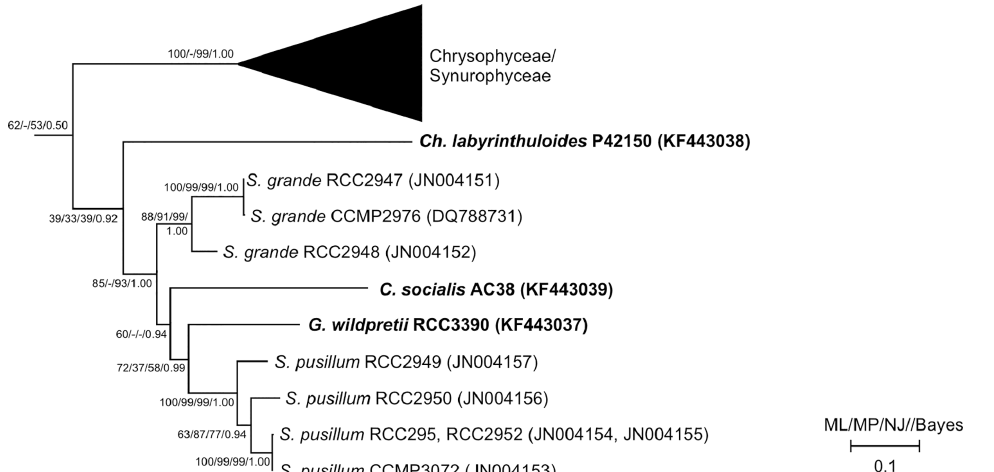
Fig 5. Phylogenetic tree of Ochrophyta using rbc L data to position Guanchochroma wildpretii and Chrysopodocystis socialis . Based on 74 photosynthetic taxa with 1231 positions. Maximum Likelihood subtree of Synchromophyceae and related photosynthetic organisms, with ML, MP and NJ bootstrap values and Bayesian posterior probabilities given at nodes. Formatting as in Fig